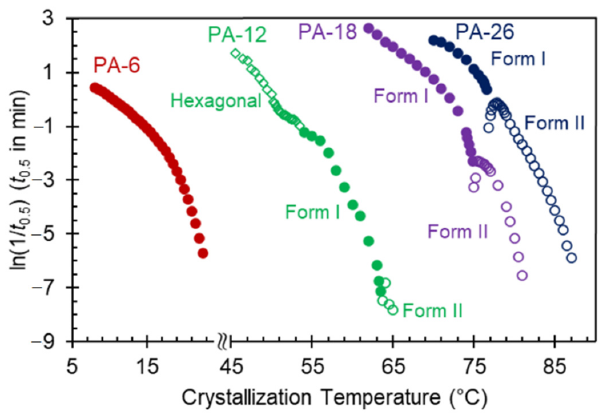
Figure 8. Overall rate of crystallization shown as the natural logarithm of the inverse half-crystallization time (1/ t 0.5 ) as a function of crystallization temperature for PA-6 (red), PA-12 (green), PA-18 (purple), and PA-26 (dark blue). Filled circles correspond to Form II, open circles to Form I, and open diamonds to hexagonal.